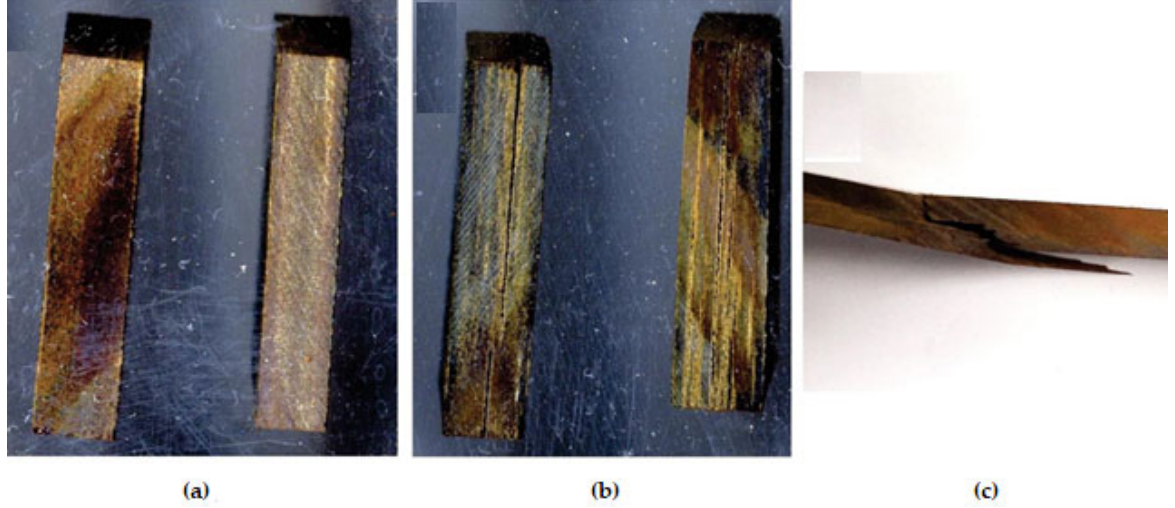
Figure 7. Cross section of L ‐ LPF ‐ 1 laminate without delamination ( a ); cross section of L ‐ LPF ‐ 5 lam ‐ inate with the appearance of delamination ( b ); fracture structure of L ‐ LPF ‐ 1 after bending strength test ( c